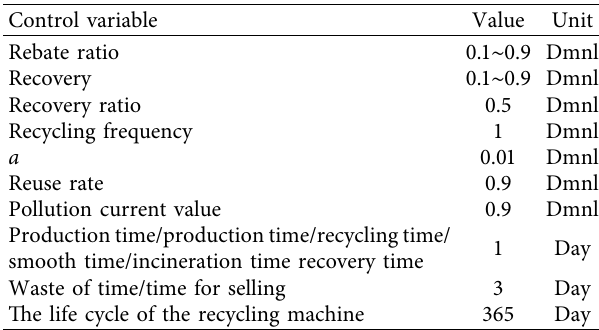
Table 1: Related parameters of double-beam-channel packaging recycling model simulation 1.